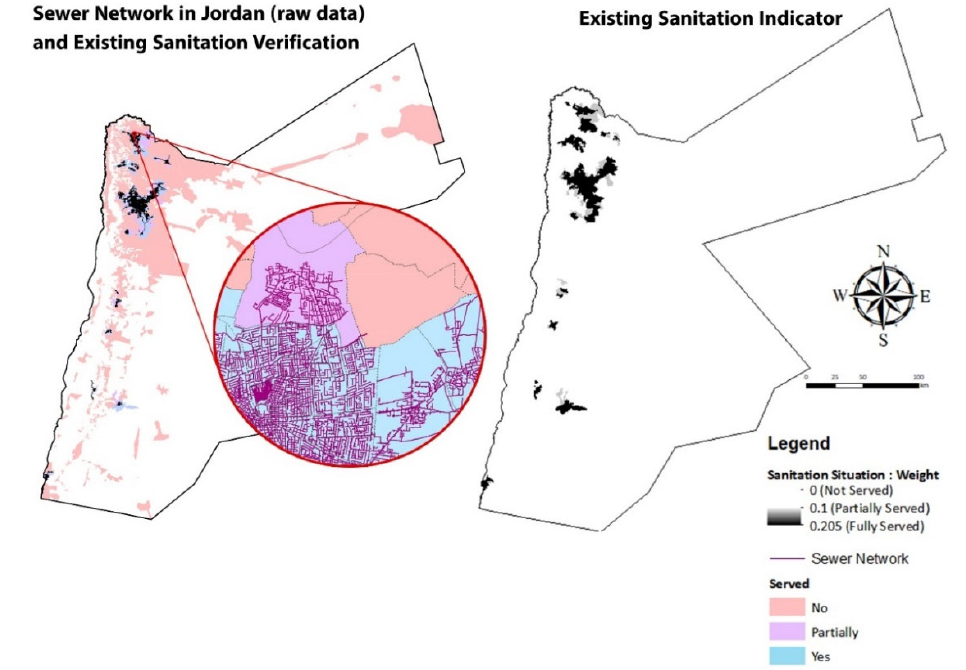
Figure 4. Existing Sanitation Services Indicator.